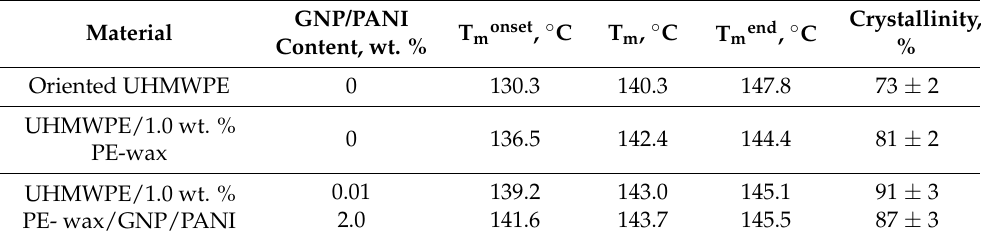
Table 6. DSC test results for the UHMWPE/1.0 wt. % PE-wax/GNP/PANI films obtained by second thermal orientation regime ( ± the standard